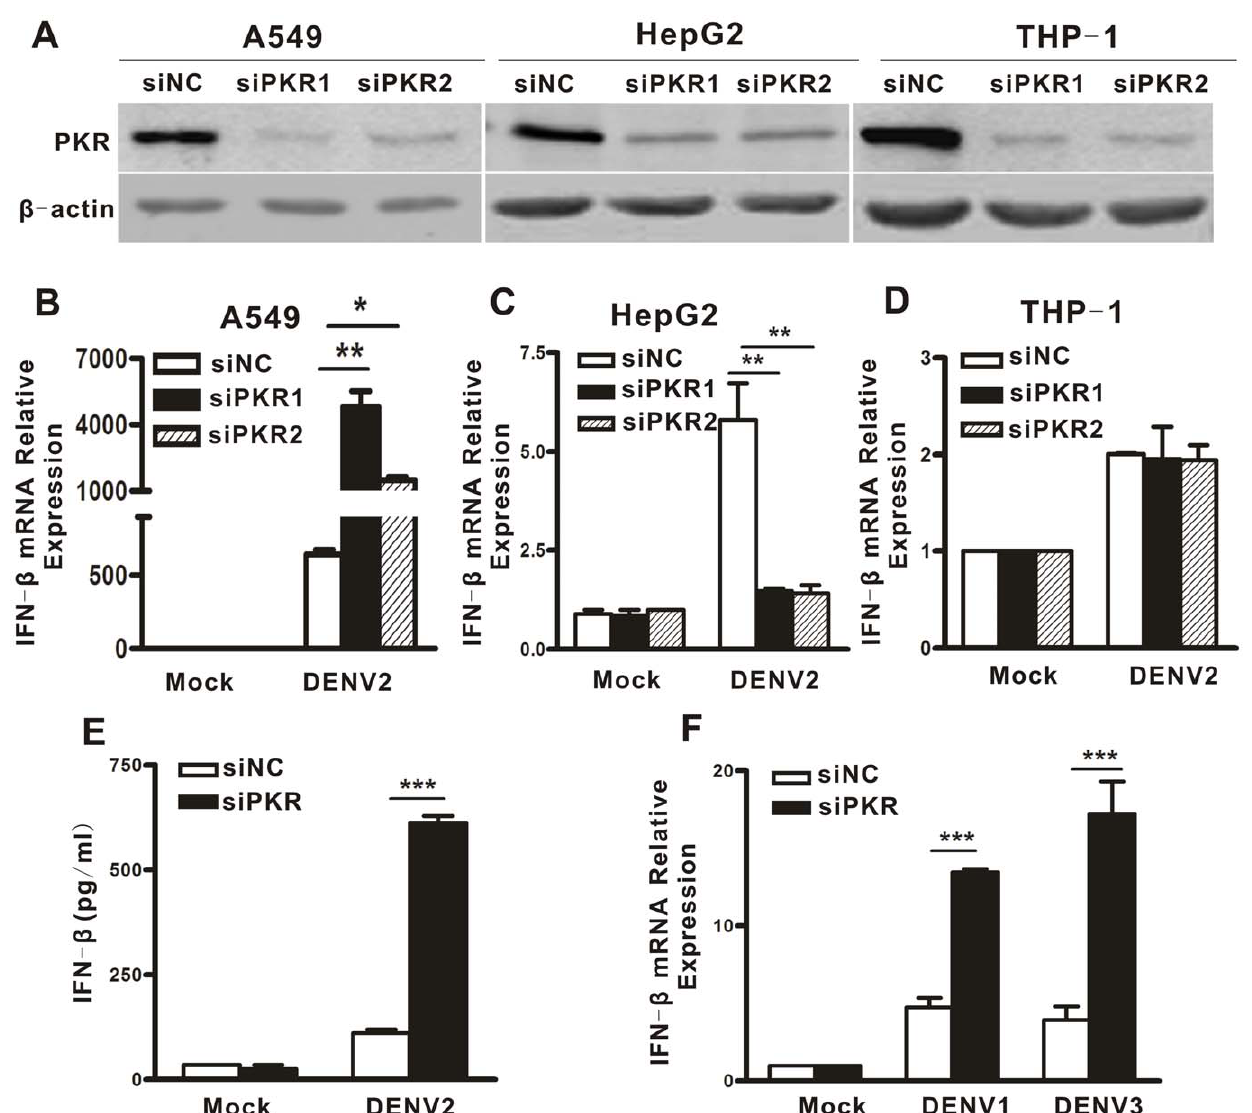
Figure 1. Knockdown of PKR significantly increased IFN- b expression following DENV infection. A549, HepG2 and THP-1 cells were transfected with siRNAs against PKR (siPKR1, and siPKR2) or control siRNA with a scramble sequence (siNC), and harvested at 48 h post transfection for Western blot (A). Transfected cells were infected with DENV2 for 16 h. Expression of IFN- b in DENV2-infected A549, HepG2 and THP-1 cells was evaluated by real-time PCR and normalized to GAPDH (B-D), ELISA was utilized to measure secreted IFN- b in A549 cells following DENV2 infection (E). Expression of IFN- b in DENV1- and DENV3- infected A549 cells was tested by real-time PCR and normalized to GAPDH (F). Data are shown as the mean 6 SEM (standard error of the mean) and represent at least three independent experiments. *p , 0.05,**p , 0.01, ***p ,